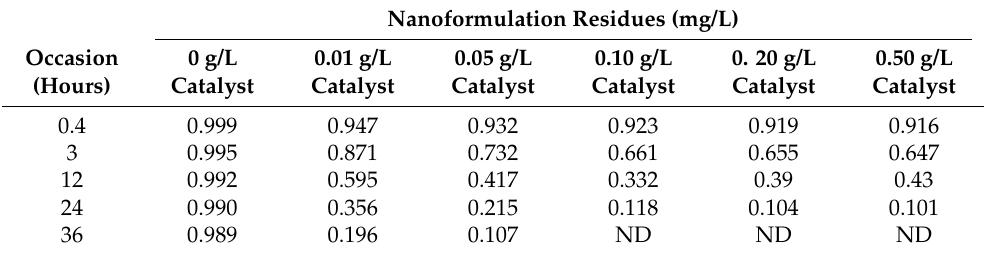
Table 1. Dissipation data for effect of catalyst amount on decontamination of nanoformulation in water under direct